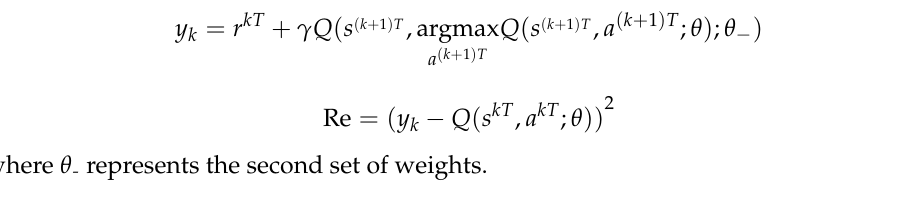
Algorithm 1: DQN with Multiple Robots in Grid